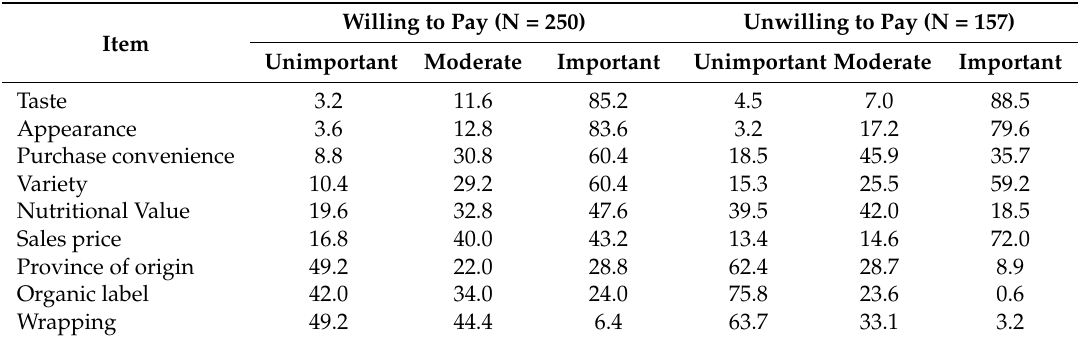
Table 2. Perception of Importance on fruit attributes. (Percent of respondents in each category) a.